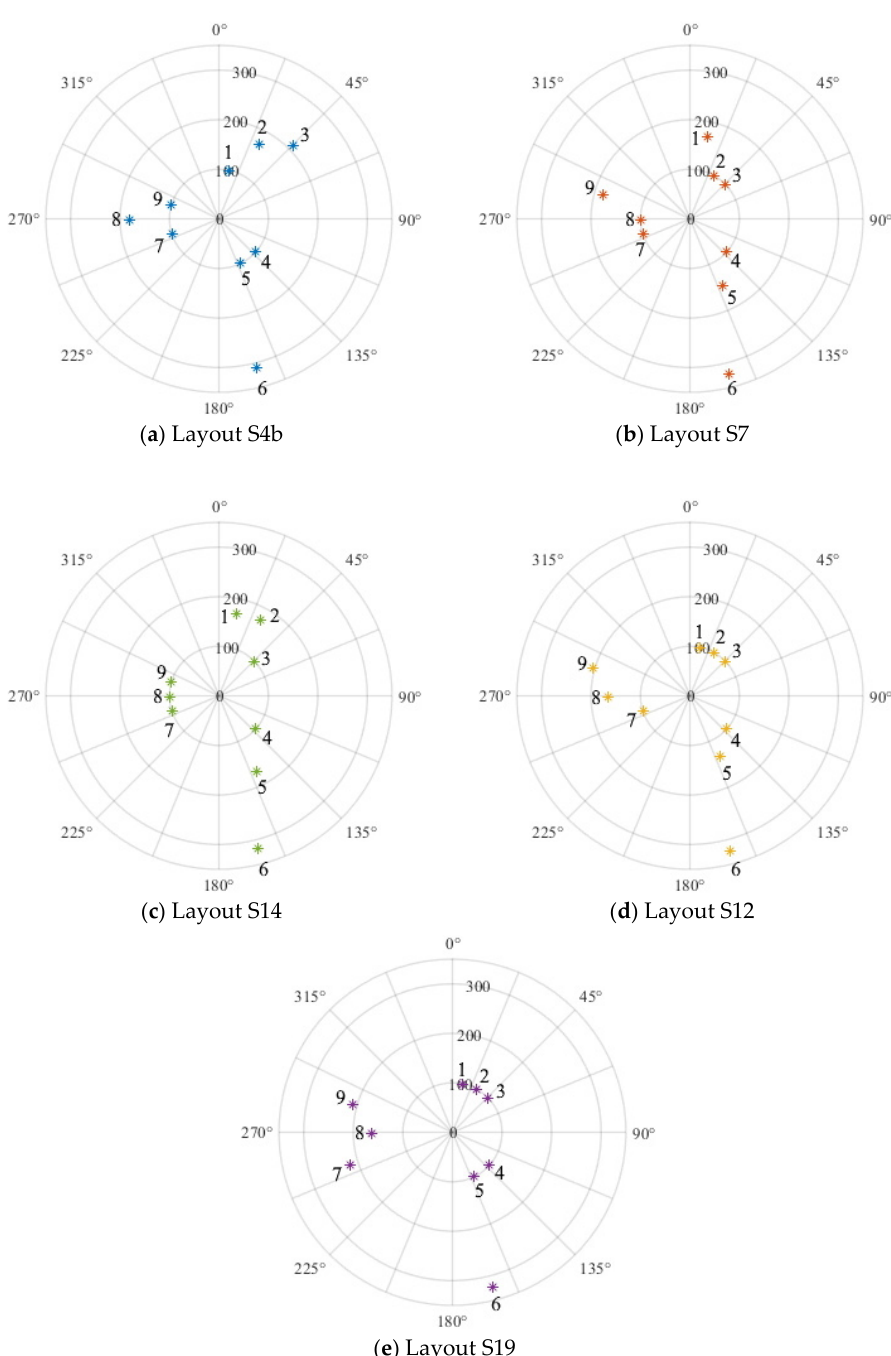
Figure 8. Representation of the I ε values on the different sensors for the different layouts in the second experimental campaign. To allow a clear graphical representation of I ε along the cylinder, each value of the I ε vector was increased by 100.